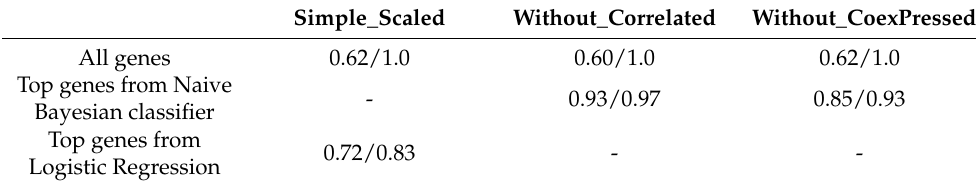
Table 3. Test/train cross-validation ROC AUC scores of SVM model, trained on all genes and genes selected by the iterative feature selection procedure with Naïve Bayesian classifier or Logistic Regression classifier. SVM model was applied to simple scaled (simple_scaled), without correlated genes (without_correlated), and without co-expressed genes (without_coexpressed) datasets. In contrast to all genes as a feature set, genes selected by the iterative procedure show predictive